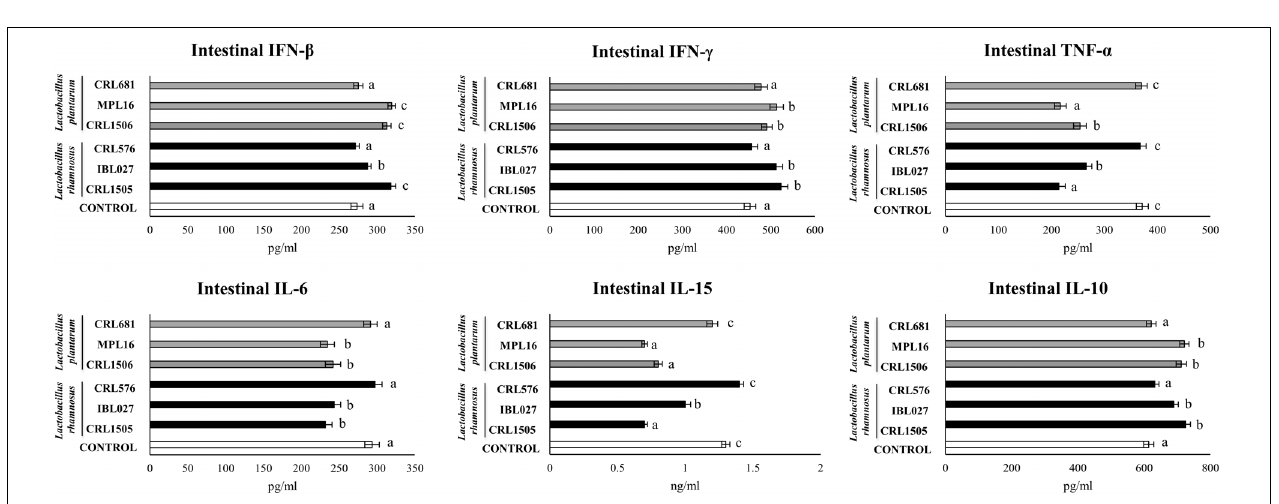
FIGURE 5 | Levels of intestinal interferons (IFN- β and IFN- γ ), proinflammatory cytokines [TNF- α and interleukin 6 (IL-6)] and IL-10 in mice orally treated with Lactobacillus rhamnosus CRL1505, L. rhamnosus IBL027, L. rhamnosus CRL576, Lactobacillus plantarum CRL1506, L. plantarum MPL16, or L. plantarum CRL681 (10 8 cells/mouse per day for 5 consecutive days) and then challenged by the intraperitoneal route with 30 µ g of the viral molecular–associated pattern poly(I:C). Mice with no lactobacilli treatment and challenged with poly(I:C) were used as controls. Immune factors were evaluated on day 2 after poly(:C) administration. The results represent data from three independent experiments ( n = 6 per group). Letters indicate significant differences ( P < 0.05), a < b <